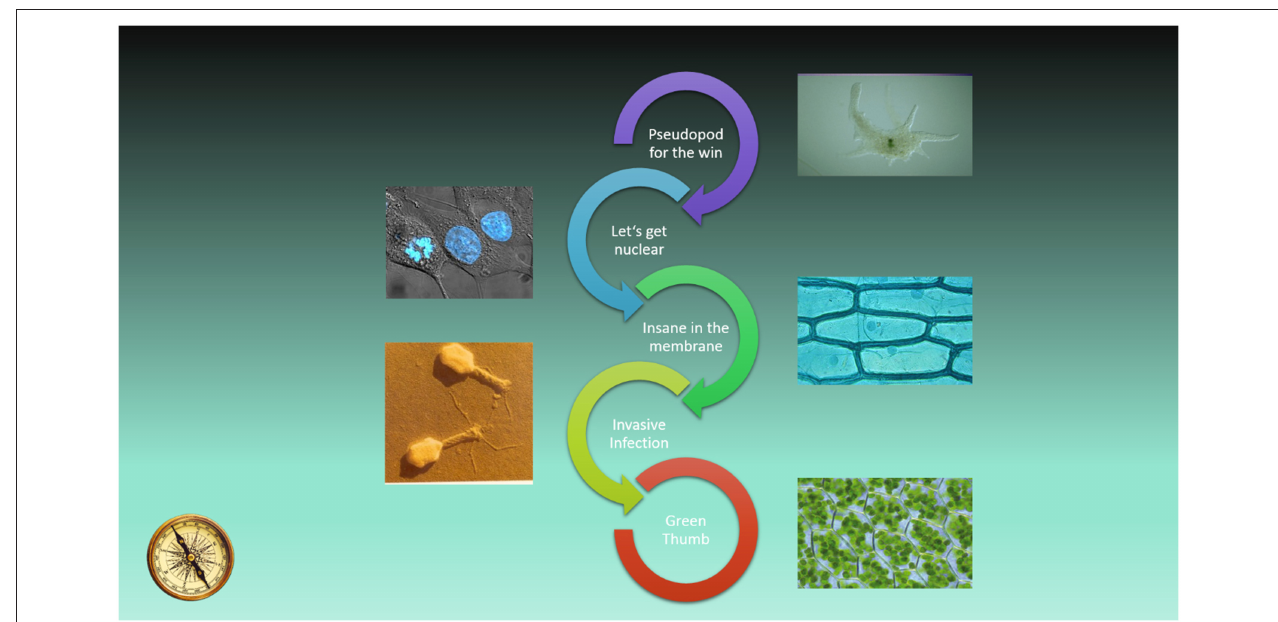
FIGURE 3 | The screenshot shows the menu of the hypertext presenting its five sections (the six images are licensed for reprint or used with the permission of the copyright holder; Anonymous, 2007, 2011; Peters, 2006; TenOfAllTrades at English Wikipedia, 2007; Yuuji, 2010; Seilnacht, 2013). The circled arrows indicate the sequence of sections. The compass in the lower left-hand area of the screen leads to the content overview.